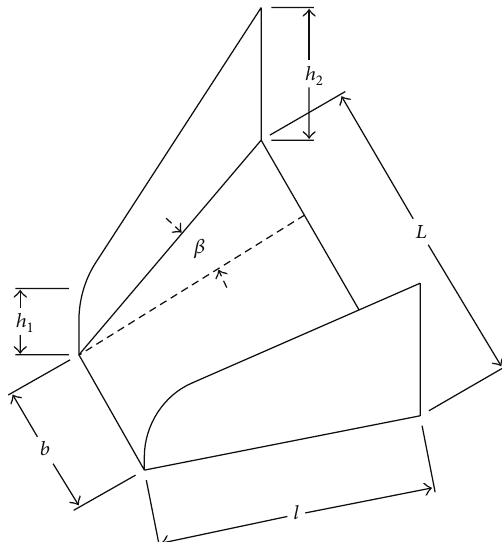
Figure 3: Nomenclature of a vane-type vortex generator (counter- rotating).